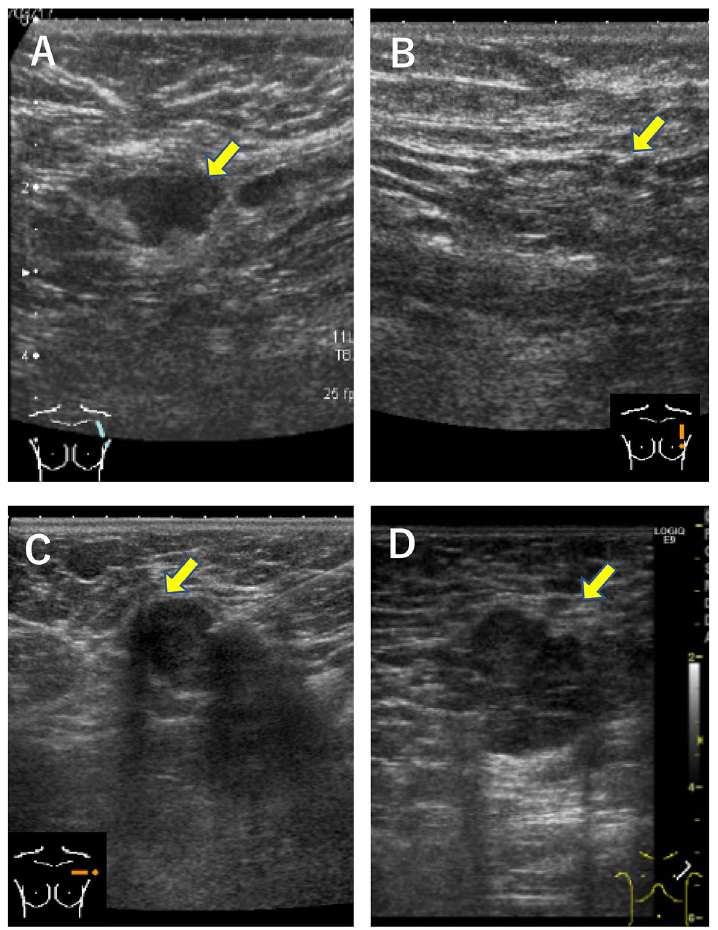
Figure 1. Representative ultrasound images. Patient 1. Before NAC, oval shaped lymph node was detected, which was cytologically confirmed as metastatic node ( A ). After NAC, lymph node shrunk, which was pathologically confirmed as negative node ( B ). Patient 2. Before NAC, ultrasound image of an axillary lymph node on fine needle aspiration showed irregular shaped lymph node, which was cytologically confirmed as metastatic node ( C ). After NAC, irregular shaped lymph node remained, which was pathologically confirmed as positive node ( D